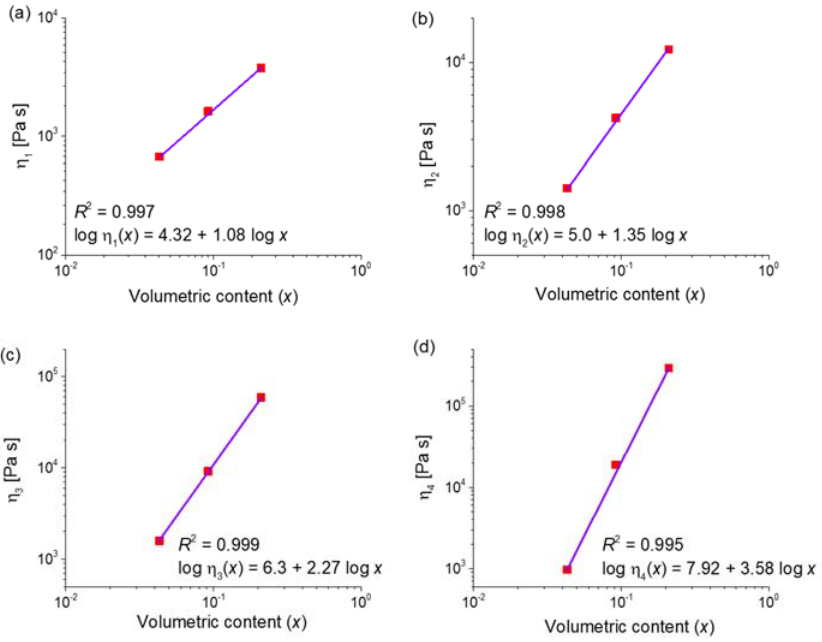
Figure 5. A comparison of the (Newtonian) viscosity parameter η i ( x ) in each mode against the filler volumetric content x (4.3%, 9.2% and 21.1%). Lines fitting based on Equation (8) (PTT model parameters in Table 1) with x > 0. ( a ) mode 1; ( b ) mode 2; ( c ) mode 3; ( d ) mode 4. Table 2. The associated parameters for the equation of viscosity functions against the filler volumetric content x for each mode of PTT model; raw data in Figure